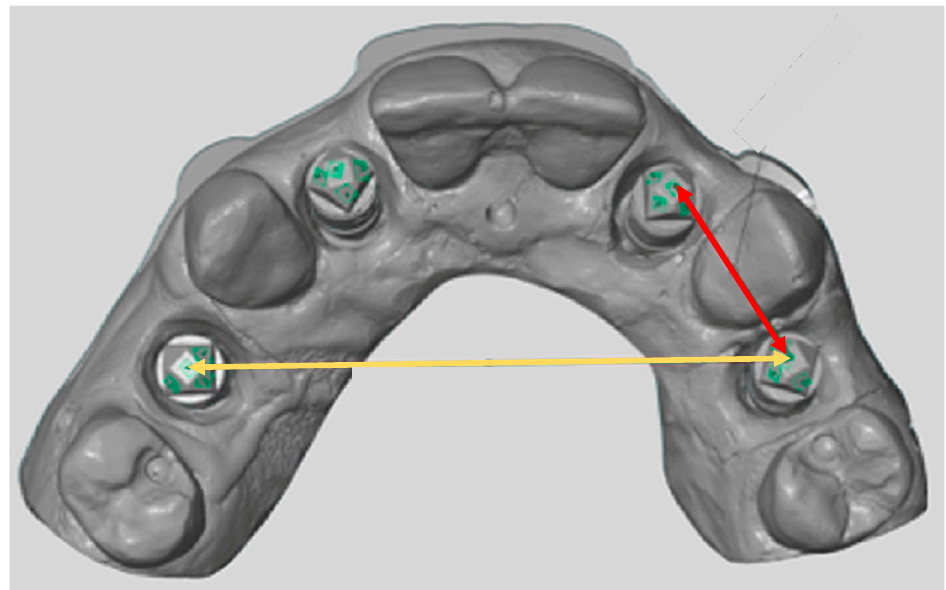
Figure 4. Linear measurements for cross-arch and same-quadrant measurements. Yellow arrow: cross-arch linear measurement between #5 scanbody and #12 scanbody; Red arrow: same-quadrant linear measurement between #10 implant and #12 implant.